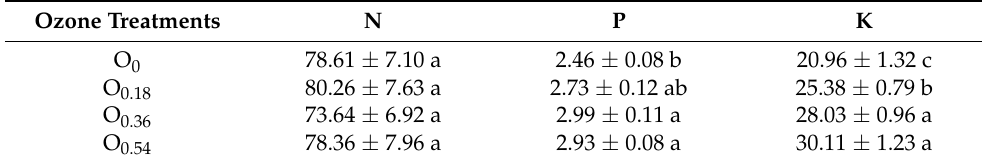
Table 10. Effect of O 3 dosage on nitrogen, phosphorous, and potassium leaf concentration (mg g − 1 DW). The data recorded are the means ± standard deviation of four samples per treat- ment at the end of the experimental period. In each column, different letters denote statistically significant changes between treatments (LSD test; p <